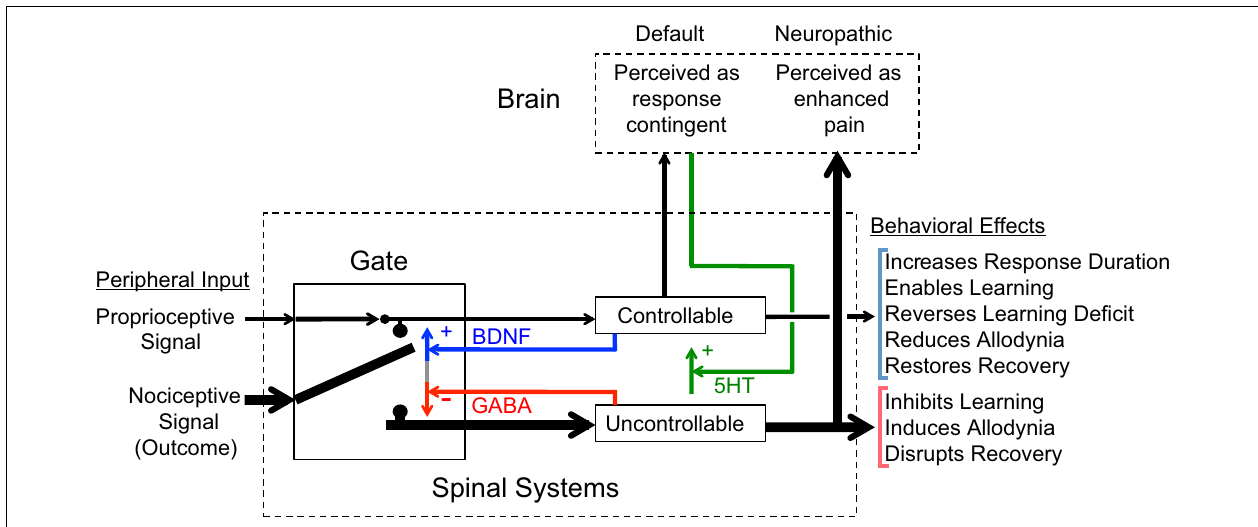
stimulation by biasing the gate in favor of controllability. Uncontrollable stimulation appears to have the opposite effect, engaging a process (red) that inhibits learning, induces allodynia, and undermines recovery after a contusion injury. Psychologically, these maladaptive effects could lead to enhanced (neuropathic) pain. GABAergic systems have been shown to play an important role in both the induction and expression of the learning deficit (Ferguson et al., 2003). Recent data also implicate the cytokineTNF-alpha (Huie et al., 2012a). For both controllable and uncontrollable stimulation, NMDAR-mediated plasticity may provide a kind of physiological latch that maintains these states over time, yielding a form of metaplasticity that enables (controllable) or disables (uncontrollable) adaptive learning. In the uninjured state, descending serotonergic (5-HT) systems (green) counter the effects of uncontrollable stimulation, which we assume helps to maintain the default state (biased in favor of adaptive